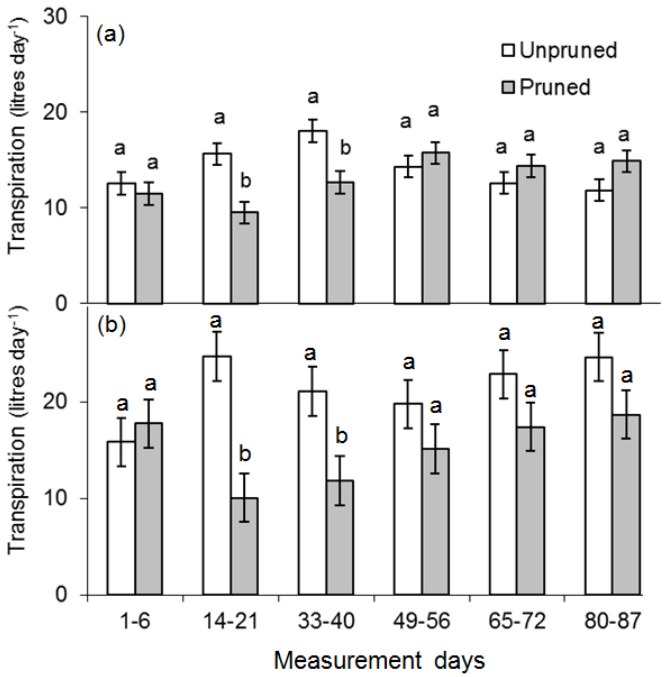
Figure 3. Mean daily transpiration during six periods (one pre-pruning from days 1–6 and five post-pruning) of fine weather throughout the measurement period for pruned and unpruned E. pilularis ( a ) and E. cloeziana ( b ). Pruning occurred on day 13. Means sharing the same letters are not significantly different for a given period. Error bars are mean standard